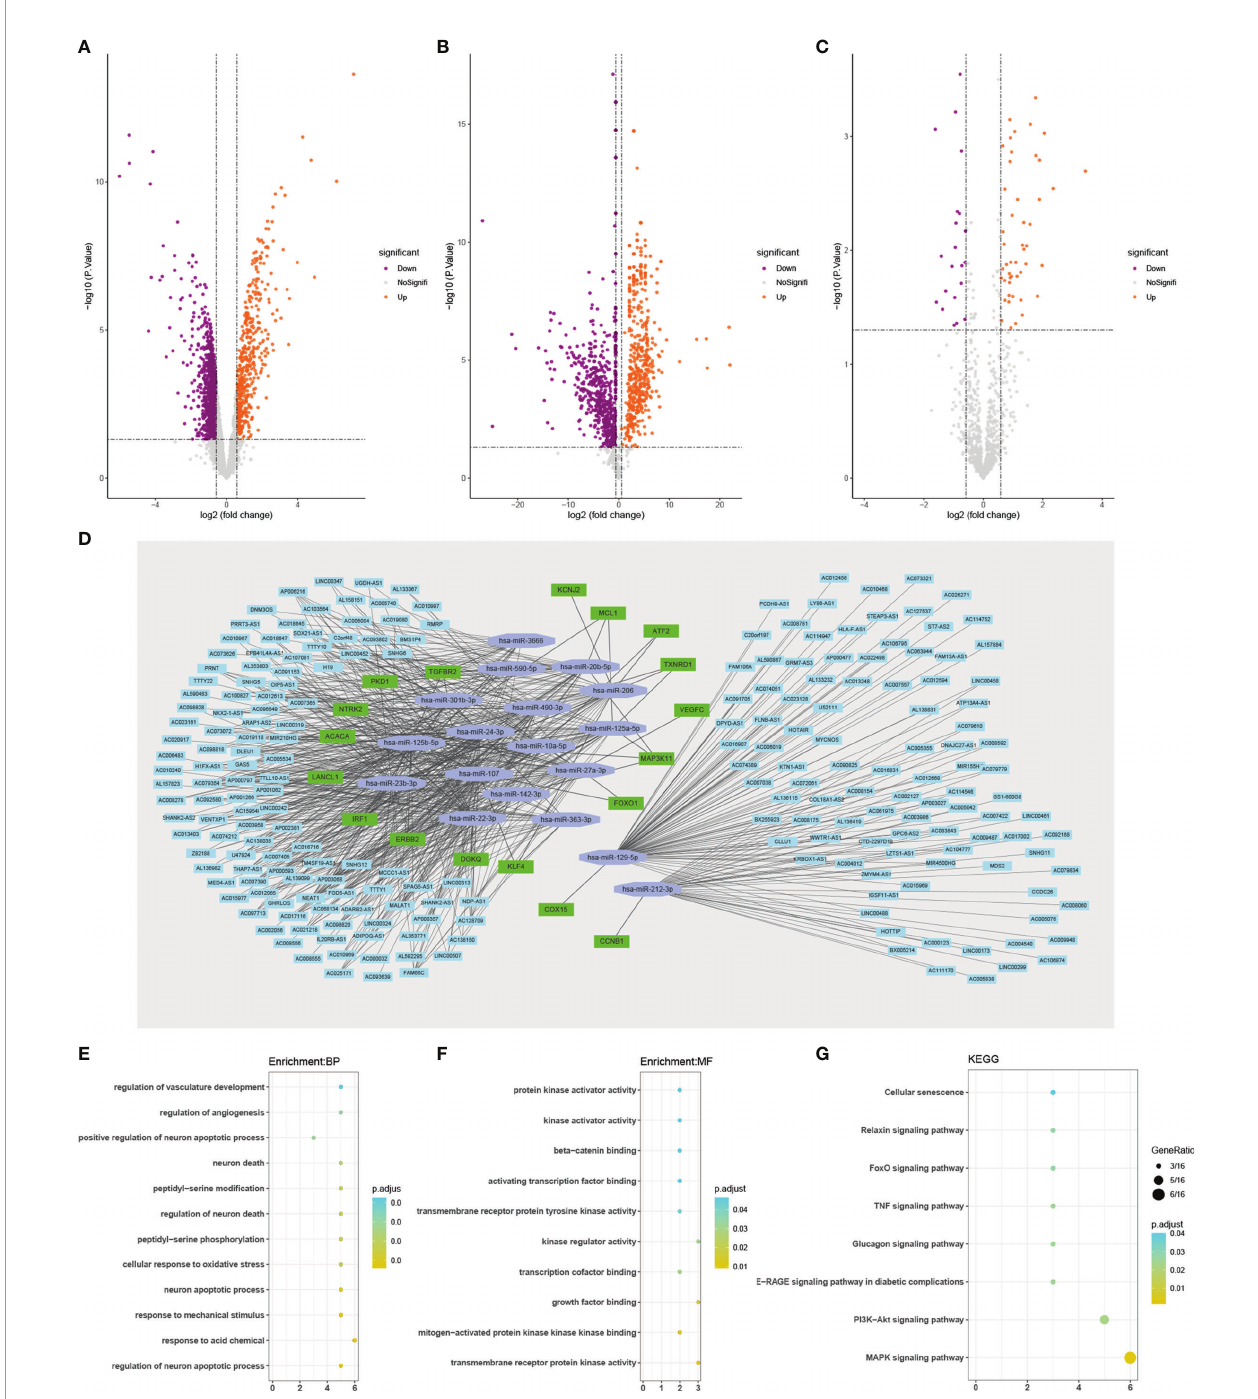
FIGURE 2 | Volcano plots of DEGs (A – C) . (A) Volcano plot of De – lncRNAs. (B) Volcano plot of De-miRNAs. (C) Volcano plot of De-mRNAs. Orange represents up- regulated differentially expressed genes, while purple represents down-regulated differentially expressed genes. The ceRNA network analyses of 18 DEOSRGs, and their function annotation by GO and KEGG (D – G) . (D) The ceRNA network analysis graph. GO enrichment analysis of 18 DEOSRGs (E, F) . (E) BP, biological process; (F) MF, molecular function. (G) KEGG pathway enrichment analysis of 18 DEOSRGs. De-lncRNAs, differentially expressed long noncoding RNAs; De – miRNAs, differentially expressed microRNAs; De-mRNAs, differentially expressed mRNAs; De – OSRGs, differentially expressed oxidative stress-related genes. GO, Gene Ontology; KEGG, Kyoto Encyclopedia of Genes and